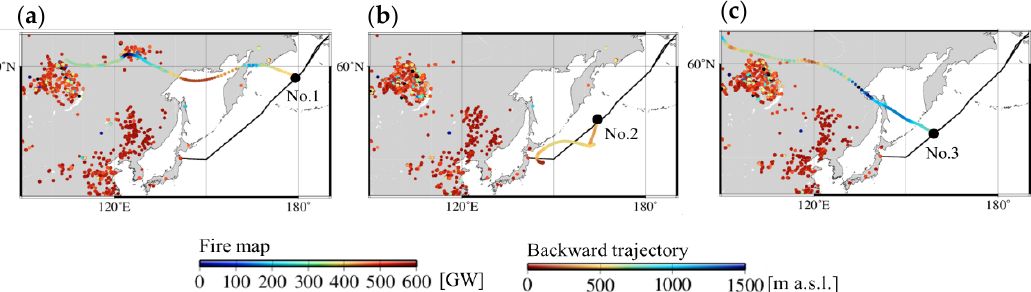
Figure 1. Sampling points for individual particle analysis in this study. The colored lines show five-day backward trajectories starting from the sampling points at 500 m a.s.l. and sampling times for ( a ) no. 1 (26 September 1:00), ( b ) no. 2 (28 September 23:00), and ( c ) no. 3 (29 September 23:00). The colored dots show the fire locations and the degree of burning during the backward trajectory period. The black circles show the sampling points. The black lines show the cruise tracks.